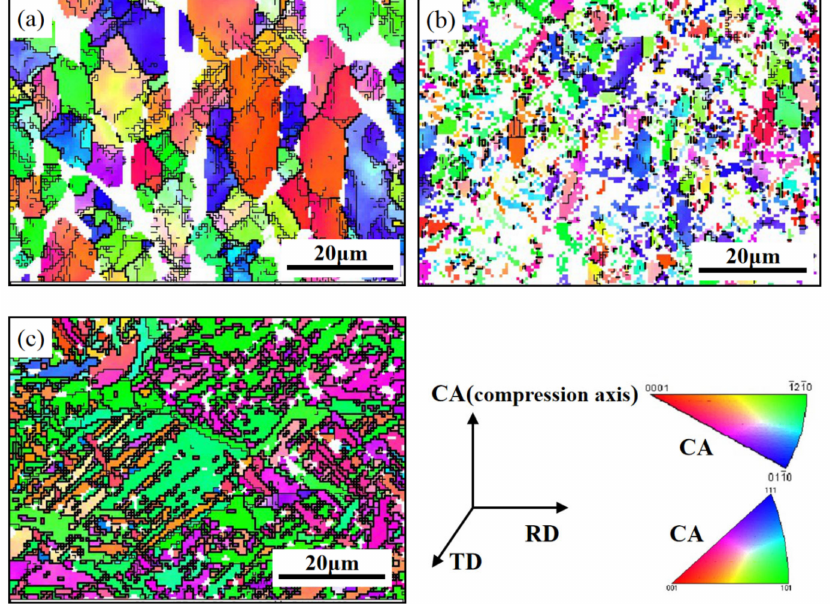
Figure 6. The inverse pole figure (IPF) maps of Ti-6.5Al-3.5Mo-1.5Zr-0.3Si alloy after deformation at: ( a ) 1123 K/0.1 s − 1 , ( b ) 1223 K/0.1 s − 1 , and ( c ) 1323 K/0.1 s − 1 . The bold black lines correspond to high-angle boundaries with misorientation over 15 ◦ , while the thin black lines represent low-angle boundaries with misorientation between 2 ◦ and 15 ◦ .